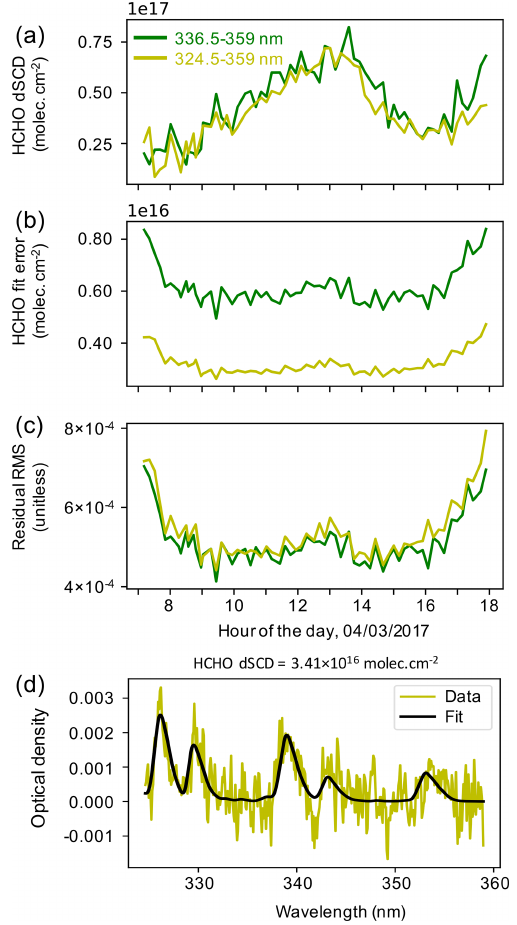
Figure 2. (a–c) Results of sensitivity tests to determine the ap- propriate fitting range for formaldehyde, using 3 ◦ elevation angle data from 4 March 2017 at Broadmeadows, showing the dSCD, the dSCD fit error and the residual RMS respectively. (d) Example 3 ◦ elevation angle HCHO DOAS fit from 11:00LT on the same